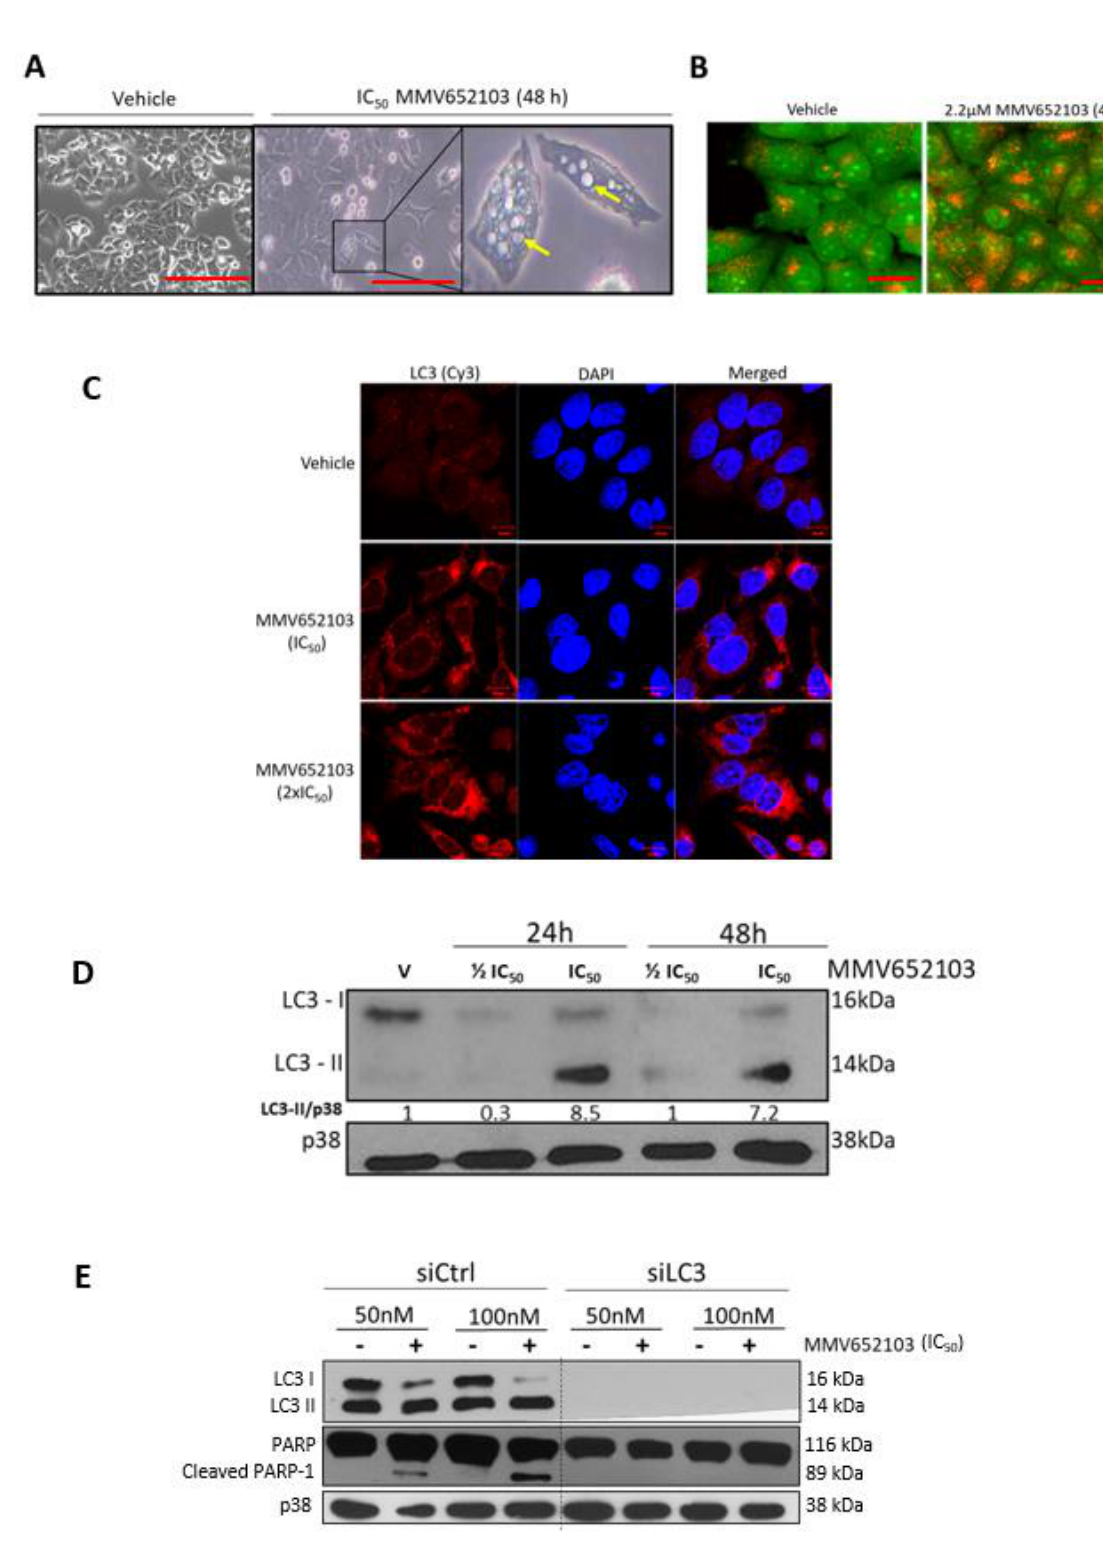
Figure 7: MMV652103 induces autophagy in MCF7 breast cancer cells. ( A ) Representative phase- contrast photomicrographs of MCF7 cells treated with vehicle (DMSO) and IC 50 MMV652103 for 48 h. Yellow arrows indicate large vacuolar structures reminiscent of autophagic vesicles. ( B ) Representative confocal images (100X; EVOS XL AMEX1000 Core Imaging System; red scale bar = 100 µm) of MCF7 cells treated for 48 h with MMV652103 and stained with acridine orange (AO) which depicts the presence of acid vesicular organelles (AVOs, yellow to orange puncta). ( C ) Representative